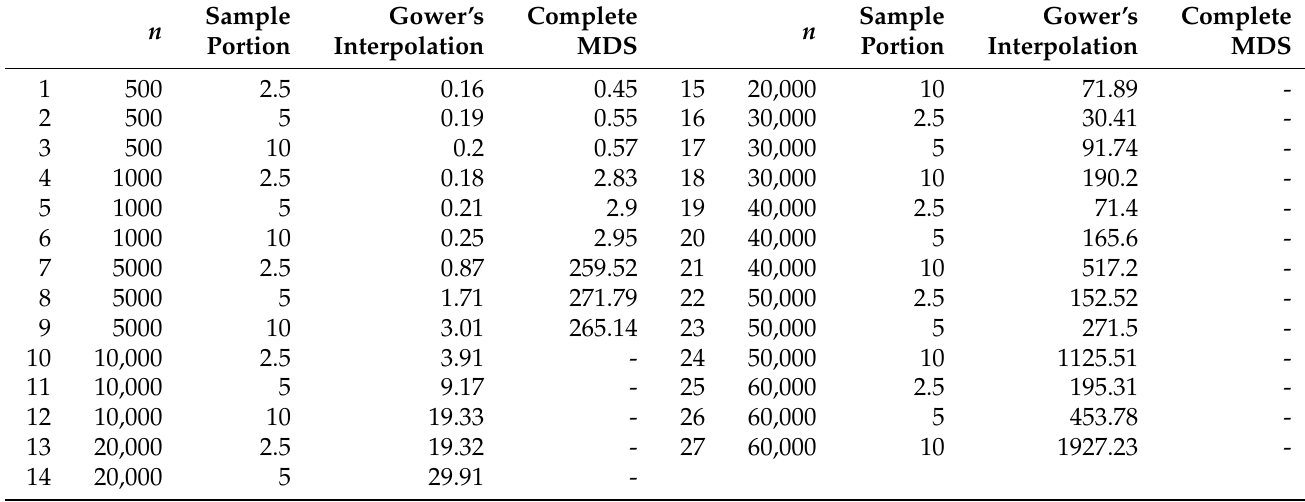
Table 4. Time required to compute weighted MDS configurations (in seconds).